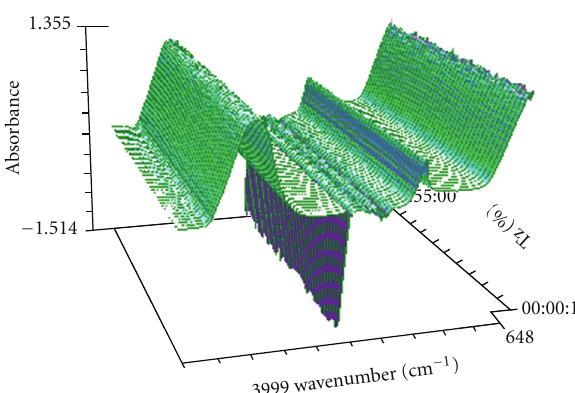
Figure 11: The 3D online infrared spectrum during the oscillation reaction.